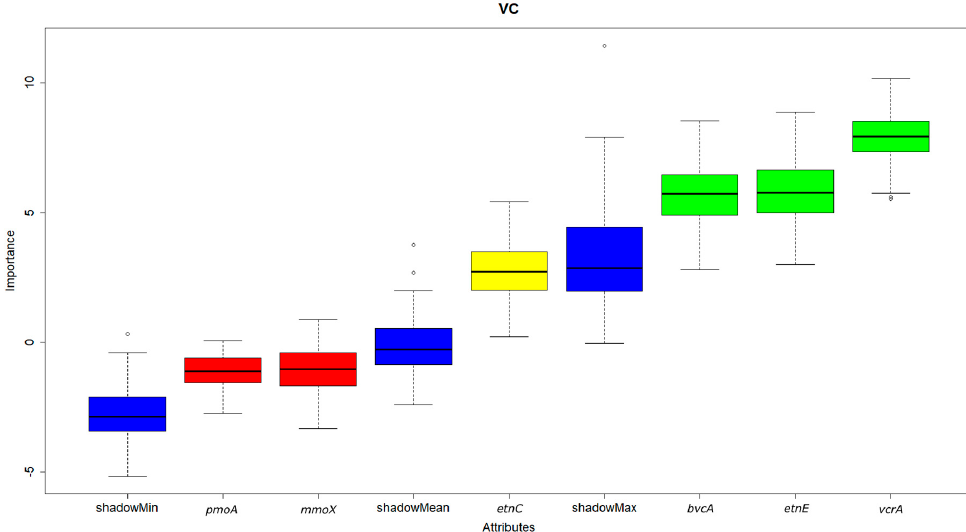
Figure 5. Importance of individual biomarkers on concentration of VC, based on the Boruta algorithm utilising the random forest classification. Green indicates significant attributes, yellow indicates attributes of intermediate significance while red indicates attributes that are not significant (blue colour indicates shadows—Boruta auxiliary features used for selection of significant attributes).